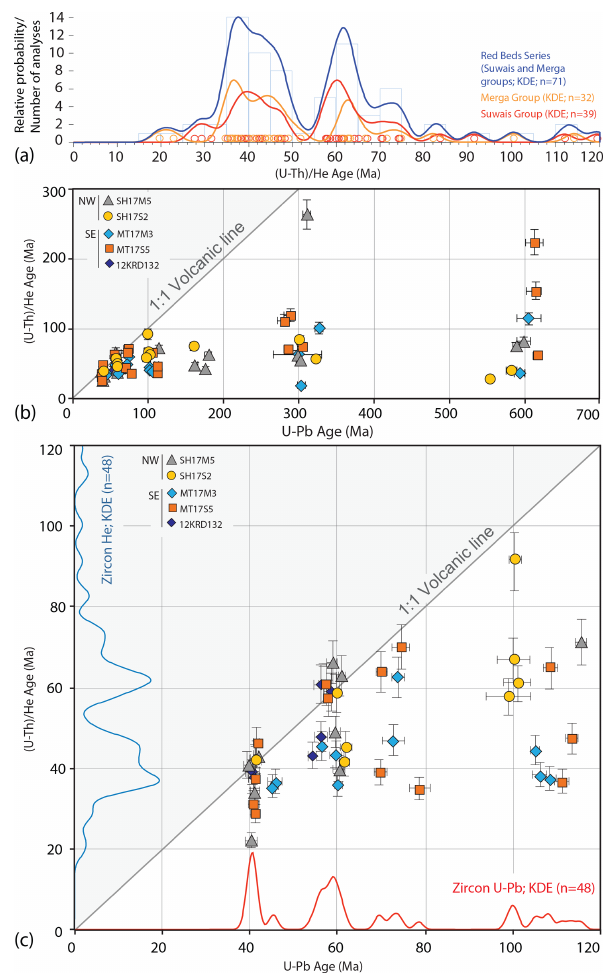
Figure 9. (a) Detrital zircon (U–Th) / He age distribution plots for the Red Beds Series units of the Suwais and Merga groups, de- picted as kernel density estimation (KDE; bandwidth = 2, bin width = 5) and age histograms (Vermeesch, 2012). (b) Detrital zircon (U– Th) / He double-dating plots of individual zircon analysis. (c) Ex- panded view of the 0–120Ma period to show detrital zircon (U– Th) / He ages for the late-Mesozoic and Cenozoic